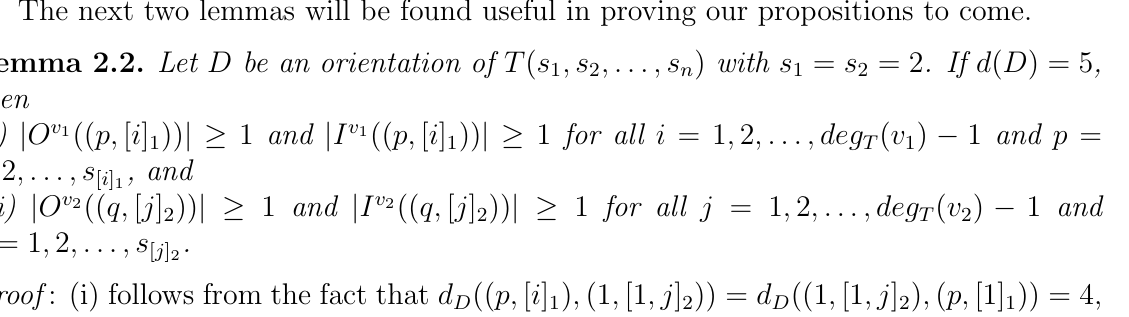
Figure 2: Orientation D for H